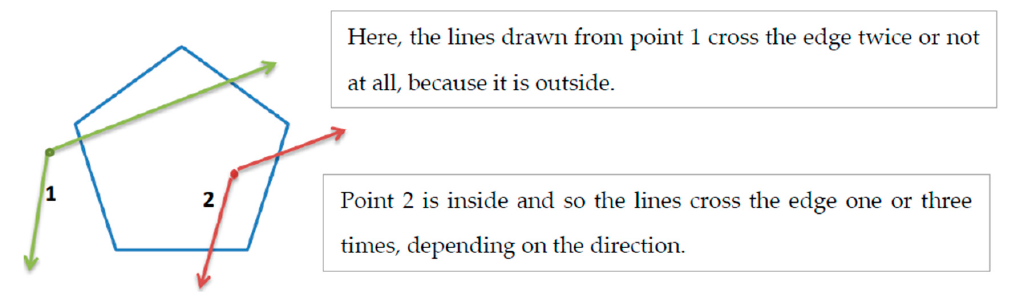
Figure 2. The principle of the point in polygon algorithm.